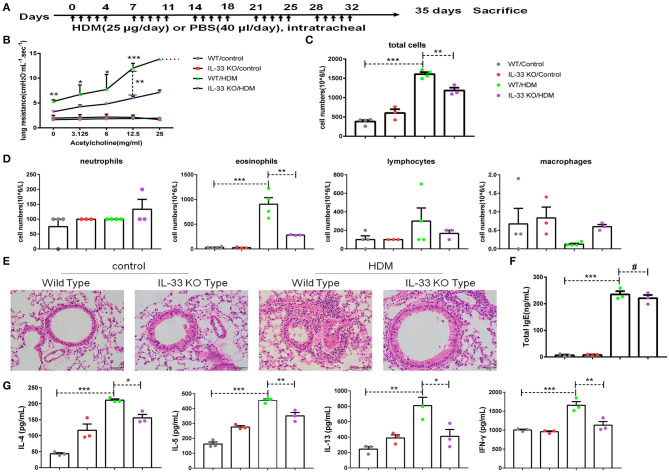
IL-33 played an important role in a mouse model of asthma. (A) Flow chart showing the chronic asthma model (5 days/week for 5 weeks). (B) Lung resistance in mice was measured with the FinePointe RC System. (C,D) The numbers of total cells, eosinophils, neutrophils, and lymphocytes in BALF were quantified. (E) Representative images of lung sections stained with H&E. (F) ELISA analysis of total IgE levels in sera. (G) ELISA analysis of IL-4, IL-5, IL-13, and IFN-γ levels in the supernatants of lung homogenates. *P < 0.05; **P < 0.01; ***P < 0.001; #P > 0.1.